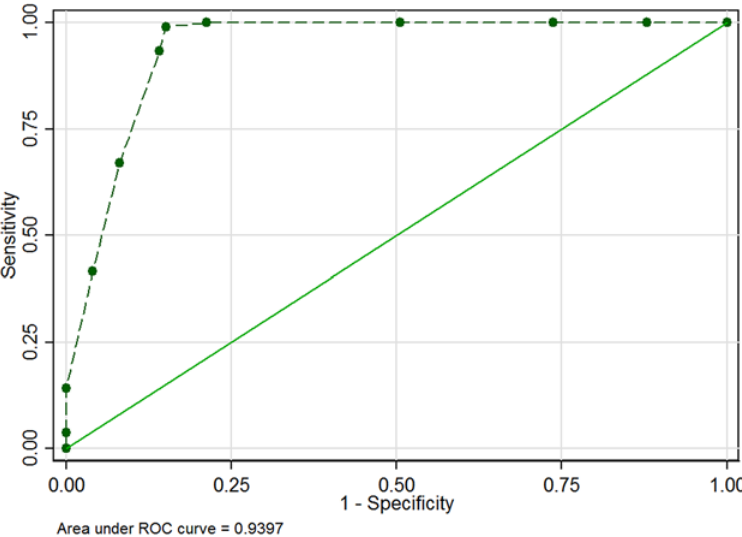
Fig 4. ROC curve of RDT performance with plotted points of considered enzyme